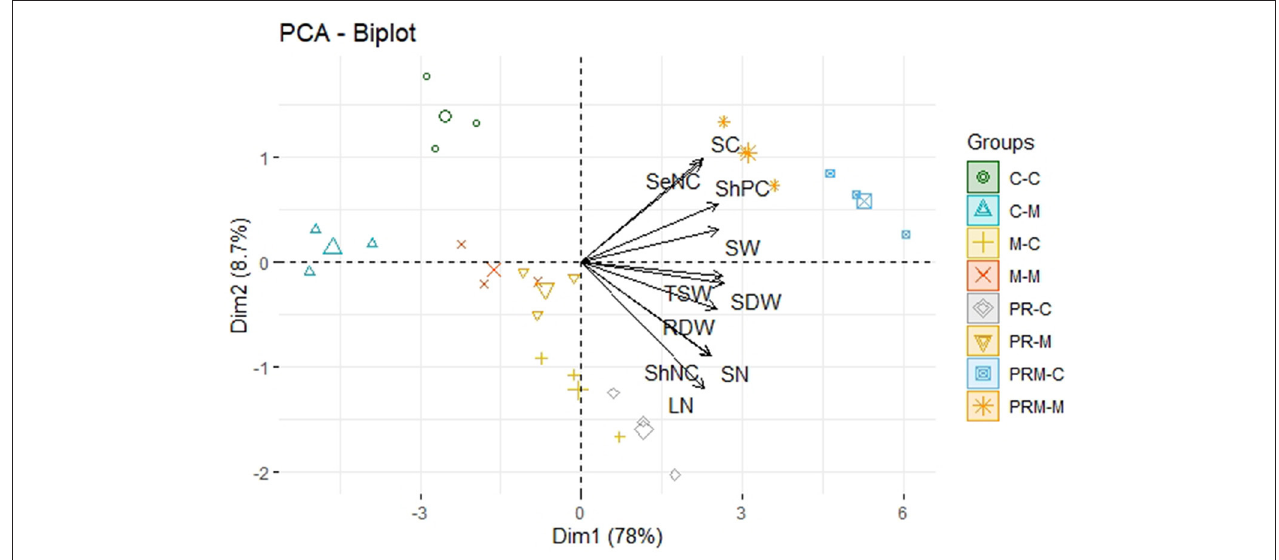
FIGURE 3 | Principal component analysis (PCA) of wheat intercropped with faba beans under × treatments (PR, inoculation with rhizobacteria consortium; M, mycorrhizae; PRM, their combination) after 5 months of growth under field conditions. SDW, shoot dry weight; RDW, root dry weight; LN, leaf number; SN, spike number; ShNC, shoot nitrogen content; TSW, thousand seed weight; SW, seed weight; ShPC, shoot phosphorus content; SC, sugar content; SeNC, seed nitrogen